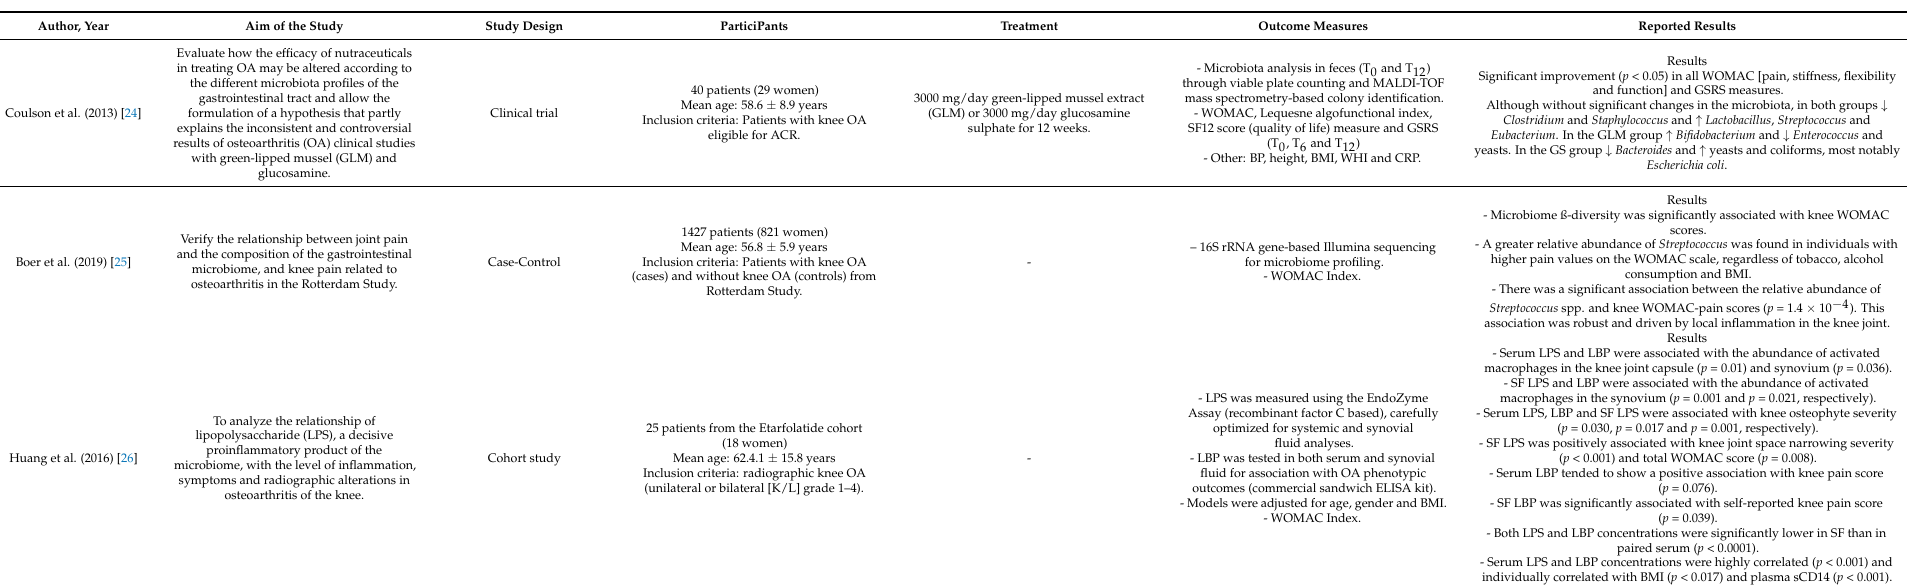
Table 1. Characteristics of included